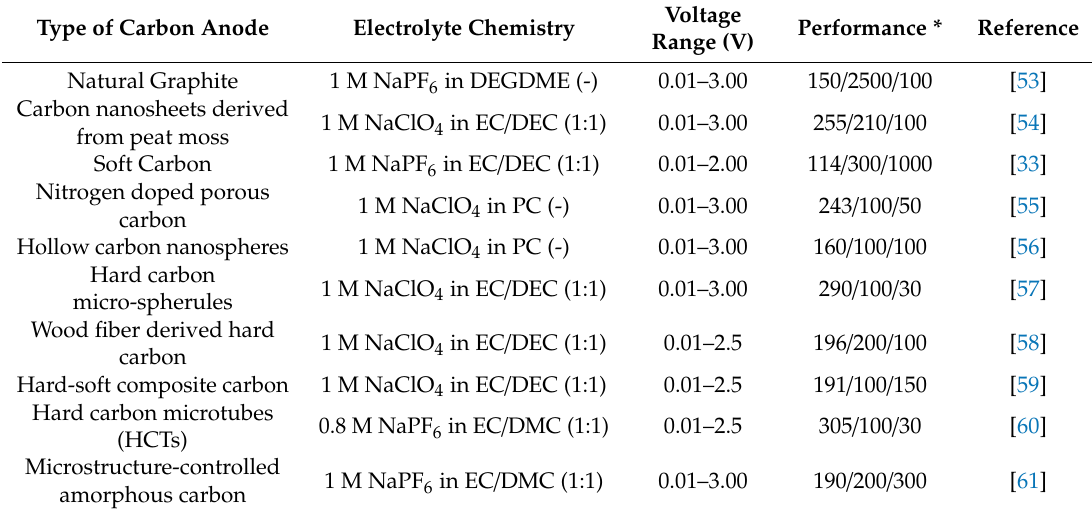
Table 1. High performance of carbon-based anodes in Na-ion battery